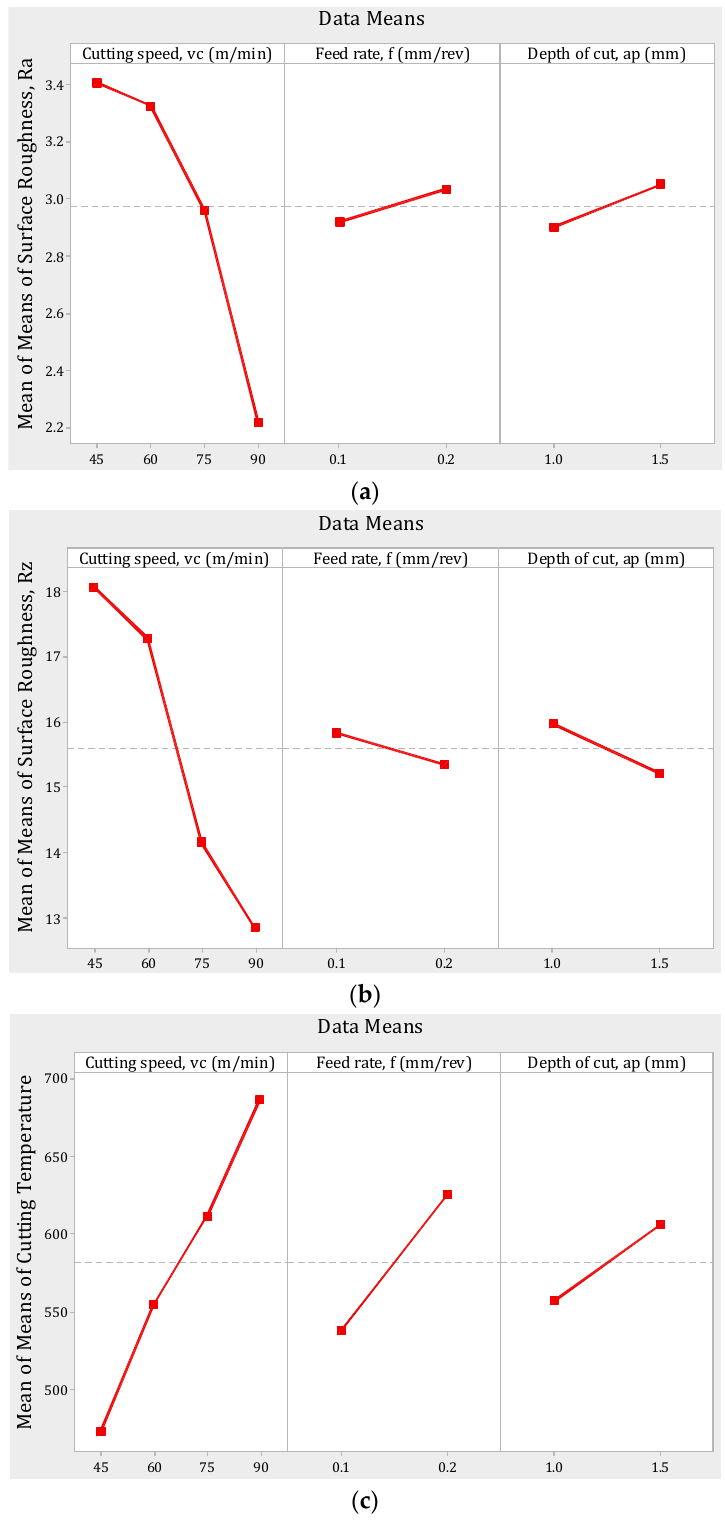
Figure 3. Effects of control factors on ( a ) mean of surface roughness, R a , ( b ) mean of surface roughness, R z , and ( c ) mean of cutting temperature.